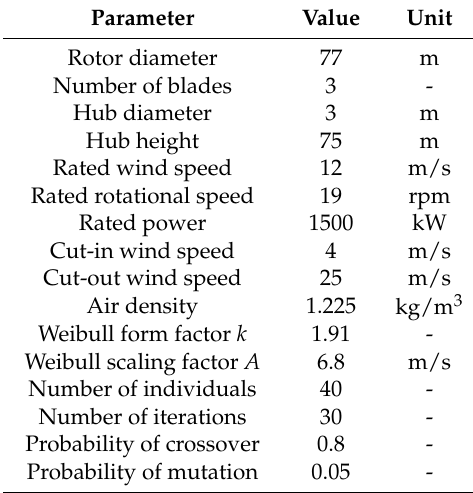
Table 4. Parameters of rotor, wind condition and non ‐ dominated sorting genetic algorithm (NSGA)-II (NSGA) ‐ II algorithm.